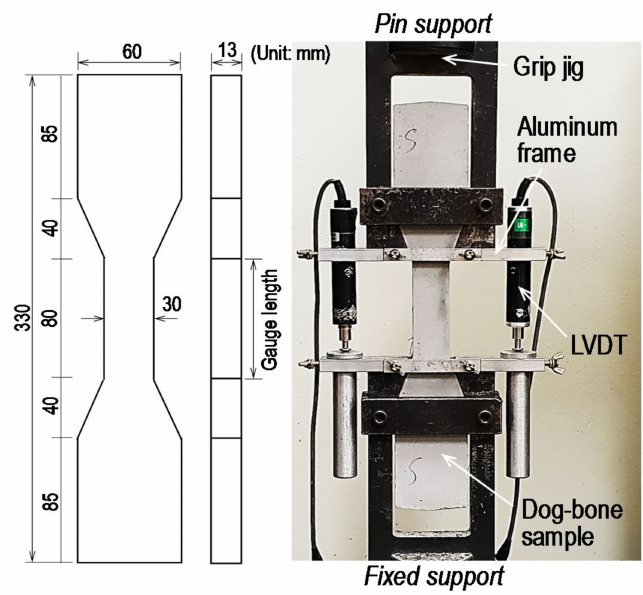
Figure 5. Direct tensile test